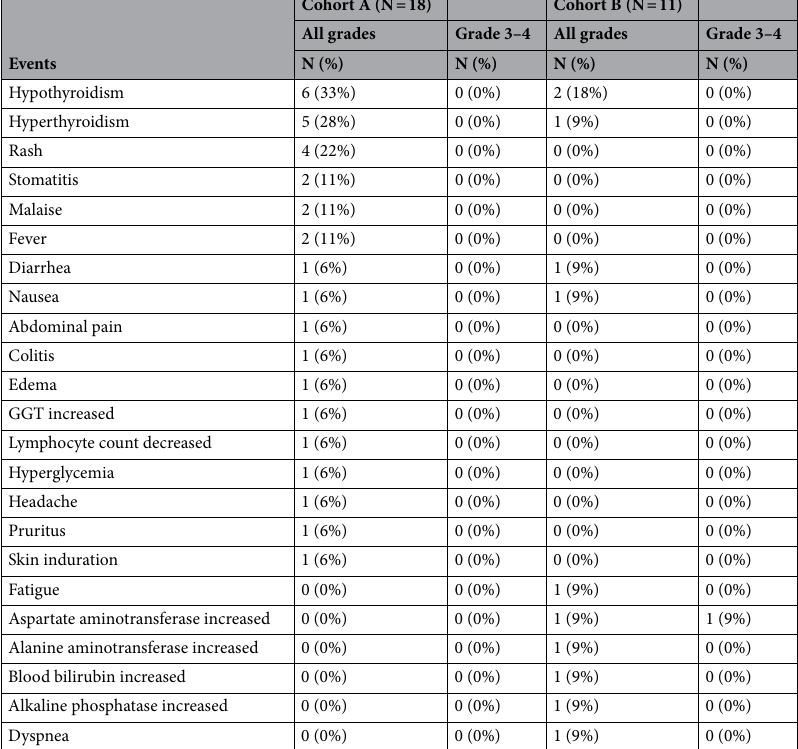
Table 3. Treatment-related adverse